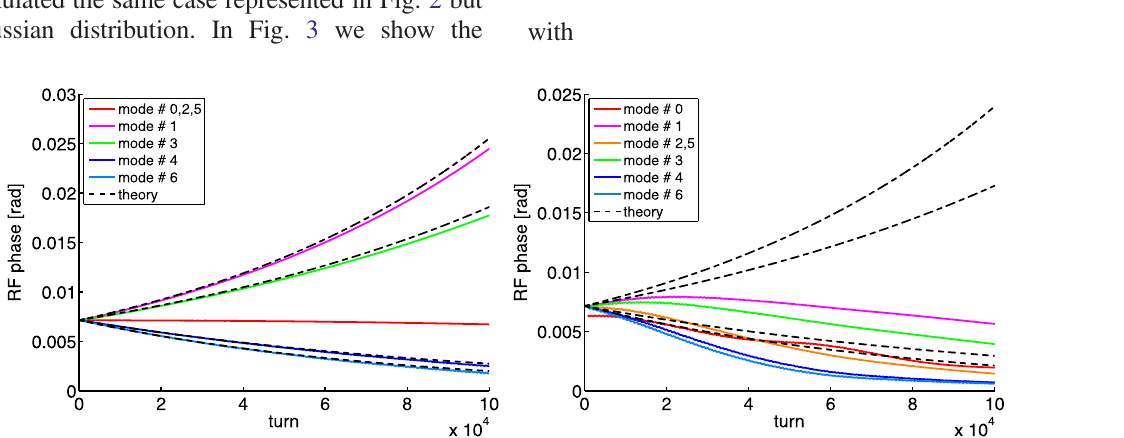
FIG. 3. Amplitude of the multibunch oscillation modes as a function of the number of turns given by M U S I C and compared with the linear theory. The bunches have a Gaussian distribution with rms bunch length equal to 0.07 rad (left side) and 0.21 rad (right side) of the rf